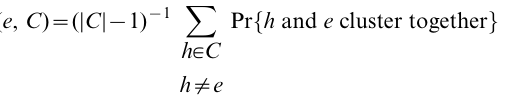
Figure 4. Evolutionary rate clusters in structured GA models ( GA s ) inferred from the HIV-1 group M pol alignment. Each cluster is labeled with the maximum likelihood estimate of its rate inferred under GA s . The residues (nodes) are annotated by their biochemical properties and Stanfel class, and the rates (edges) are labeled with model-averaged ( GA r ) rate estimates. The style of an edge is determined by its cluster affinity, where high cluster affinities indicate that a large proportion of models in the credible set were consistent with the structured GA s